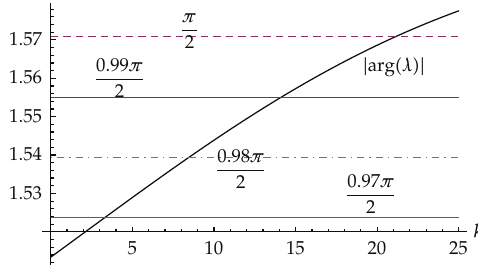
Figure 7: Estimate for the control k